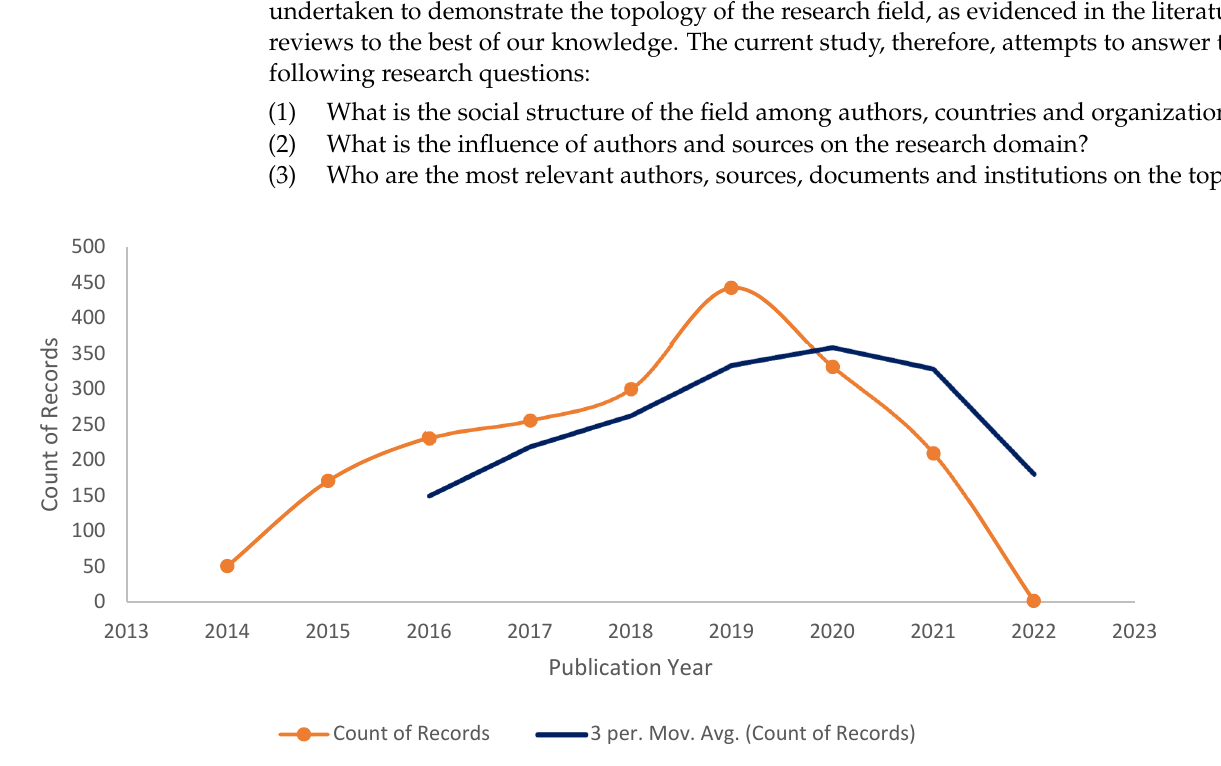
Figure 2. Document Count Trend. The three-period moving average depicts the true trend of record against the publication